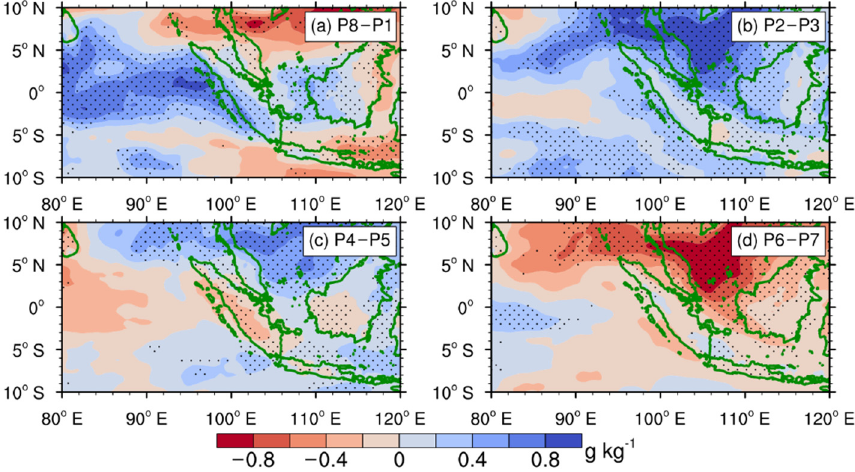
Figure 6. The anomalies of water vapor mixing ratio at 850 hPa (g kg − 1 ) in ( a ) P8–P1, ( b ) P2–P3, ( c ) P4–P5 and ( d ) P6–P7. The black dots indicate the 95% confidence according to the Student’s t